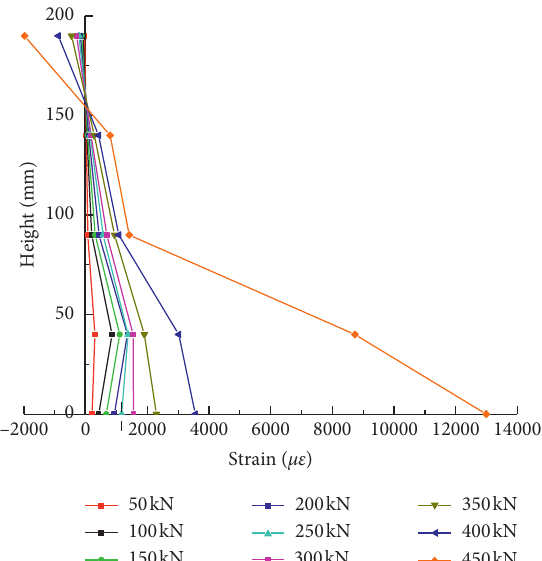
Figure 8: Strain distribution of steel in midspan.